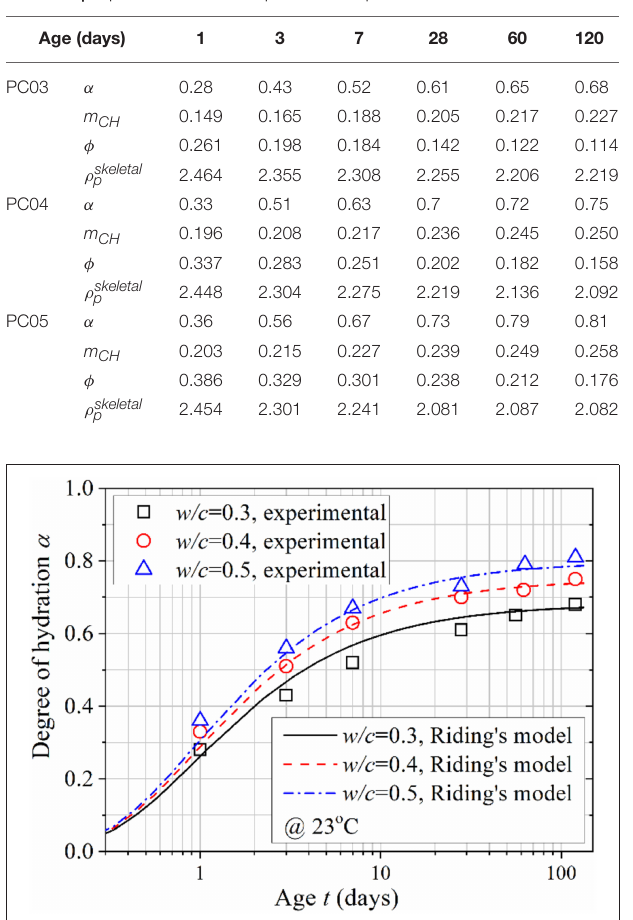
FIGURE 1 | Comparison of the degrees of hydration data and Riding’s model.